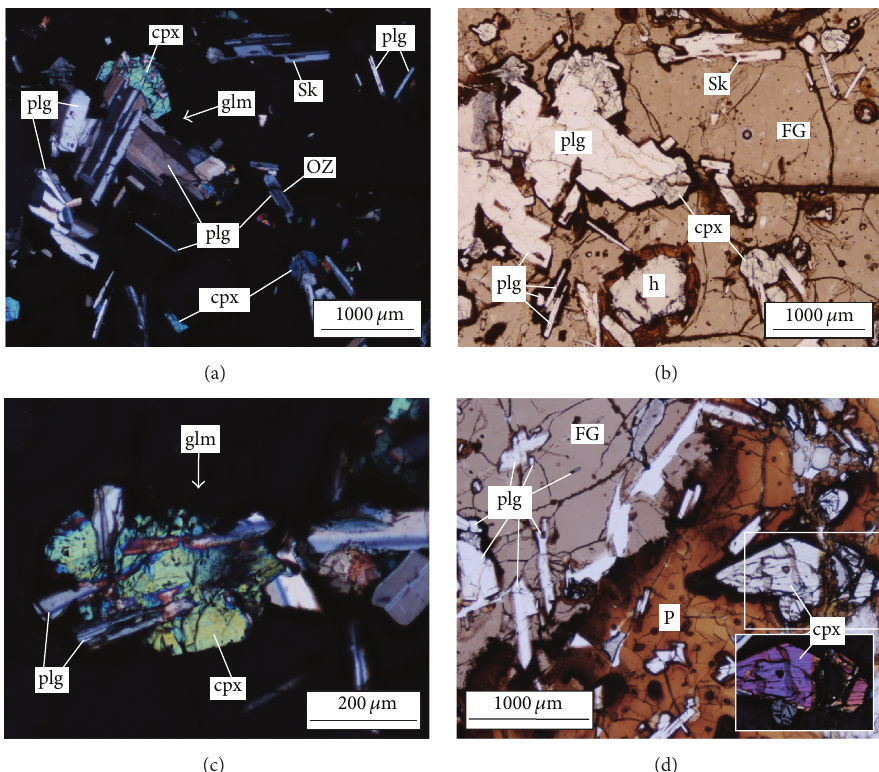
Figure 6: Photomicrographs of polished petrographic thin sections of DSDP 418A basaltic glass pillow margins, highlighting various igneous petrographic features. The photomicrographs shown in (a, c) and (d—“inset”) are taken in cross polarized light (crossed nicols), whereas (b) and (d) are in plane polarized light (uncrossed nicols). (a-b): sample DSDP-418A-75-3[120–123] . (c-d): sample DSDP-418A-68-3[40–43] . Note that (a) and (b) depict the same petrographic area. cpx: clinopyroxene; FG: fresh basaltic glass; glm: glomerocryst; h: artificial hole in